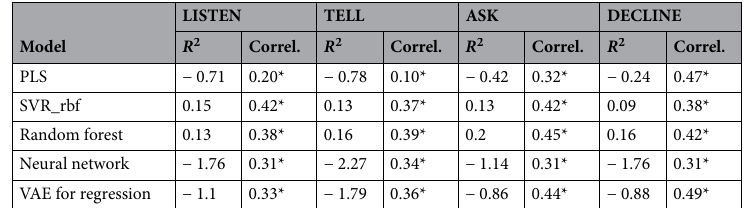
Table 4. Model comparison: * denotes significant correlation in no-correlation test (p<0.05).